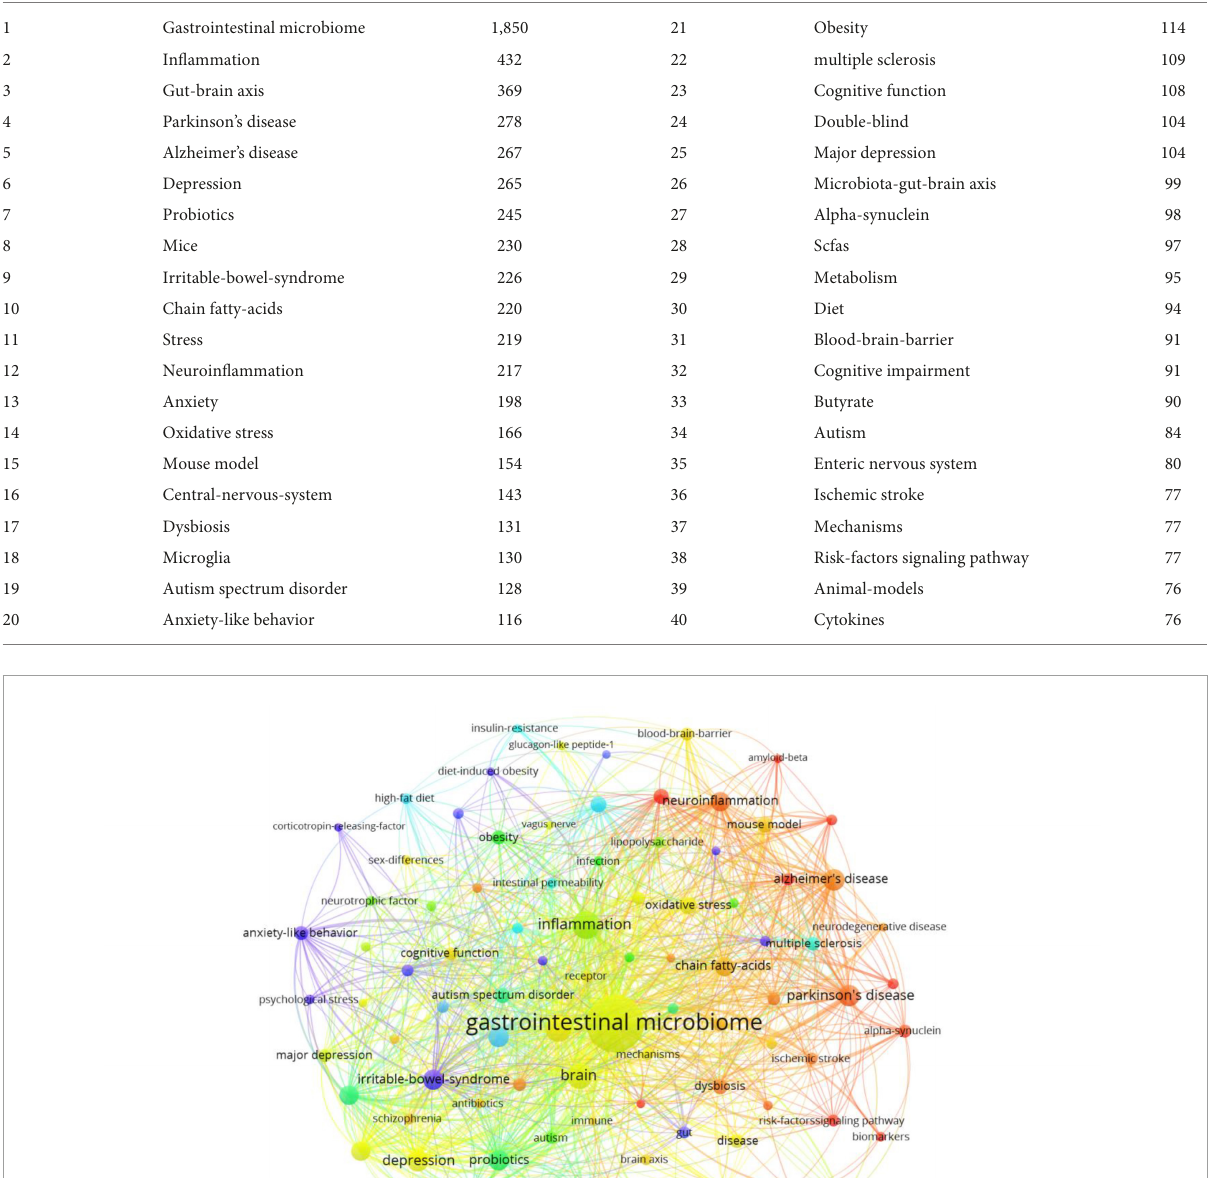
TABLE 7 The top 40 keywords related to research in gastrointestinal microbiome and neuroscience.